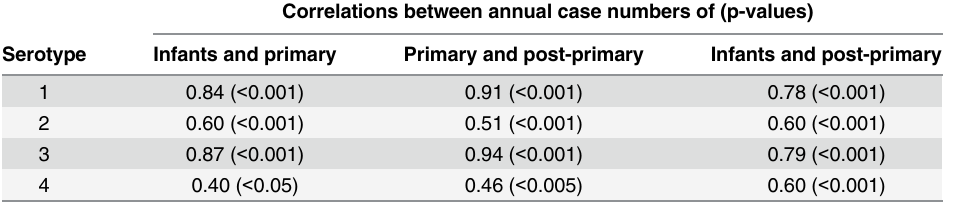
Table 3. Correlations between the case numbers of each serotype in each immune group each year, p-values are shown in brackets. Correlations between annual case numbers of (p-values)